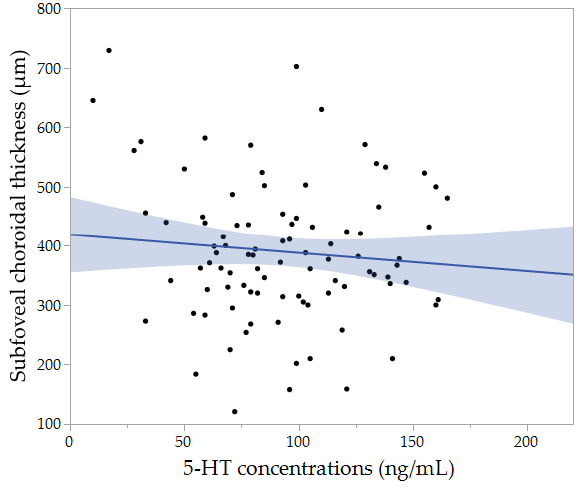
Figure 2. The association between subfoveal choroidal thickness and 5-HT concentrations; No association was found between subfoveal choroidal thickness and 5-HT concentrations ( r = −0.056, p = 0.5937).